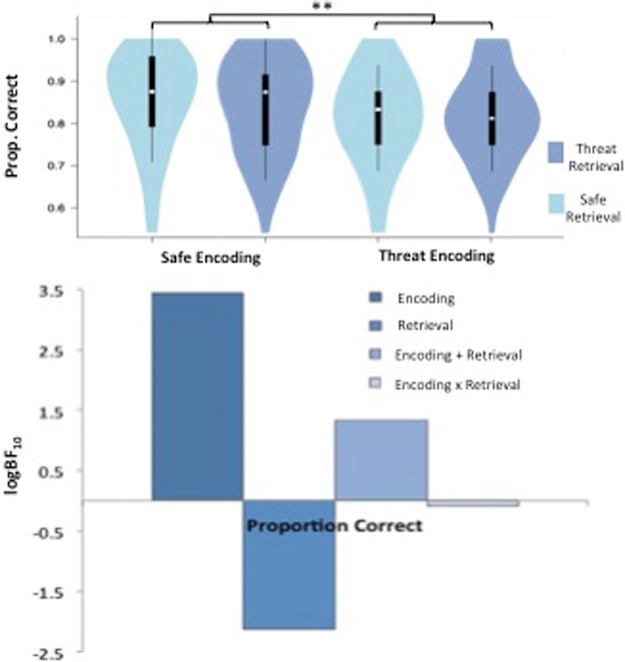
Facial recognition task results. Violin plots displaying proportion correct for each condition, and bar charts representing the Bayesian model evidence for proportion correct for each condition.